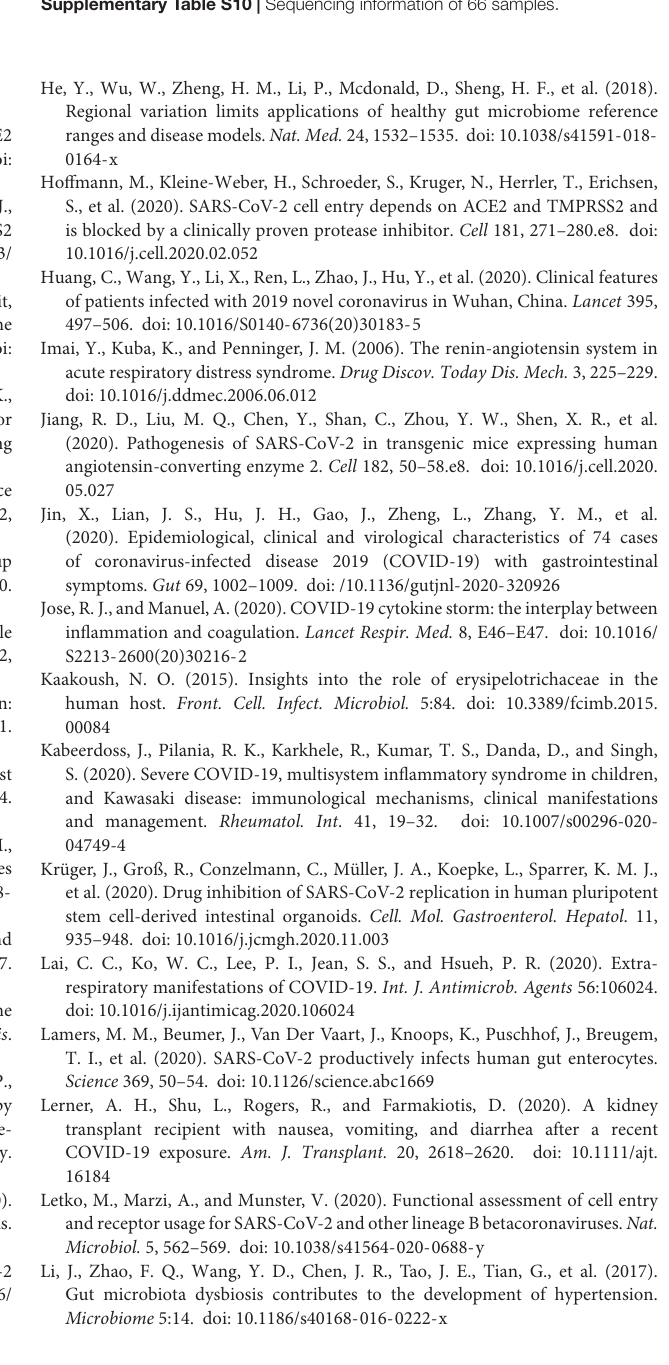
Supplementary Figure S4 | The β diversity of ABX-treated and non-treated patients. Supplementary Table S1 | The laboratory results of complete blood count and blood chemistry of COVID-19 patients ( n = 47) and healthy controls ( n = 19). Supplementary Table S2 | Demographic profiles and drug treatment history of study participants. Supplementary Table S4 | Gut microbial compositions at family level of the discovery cohort (n = 37).